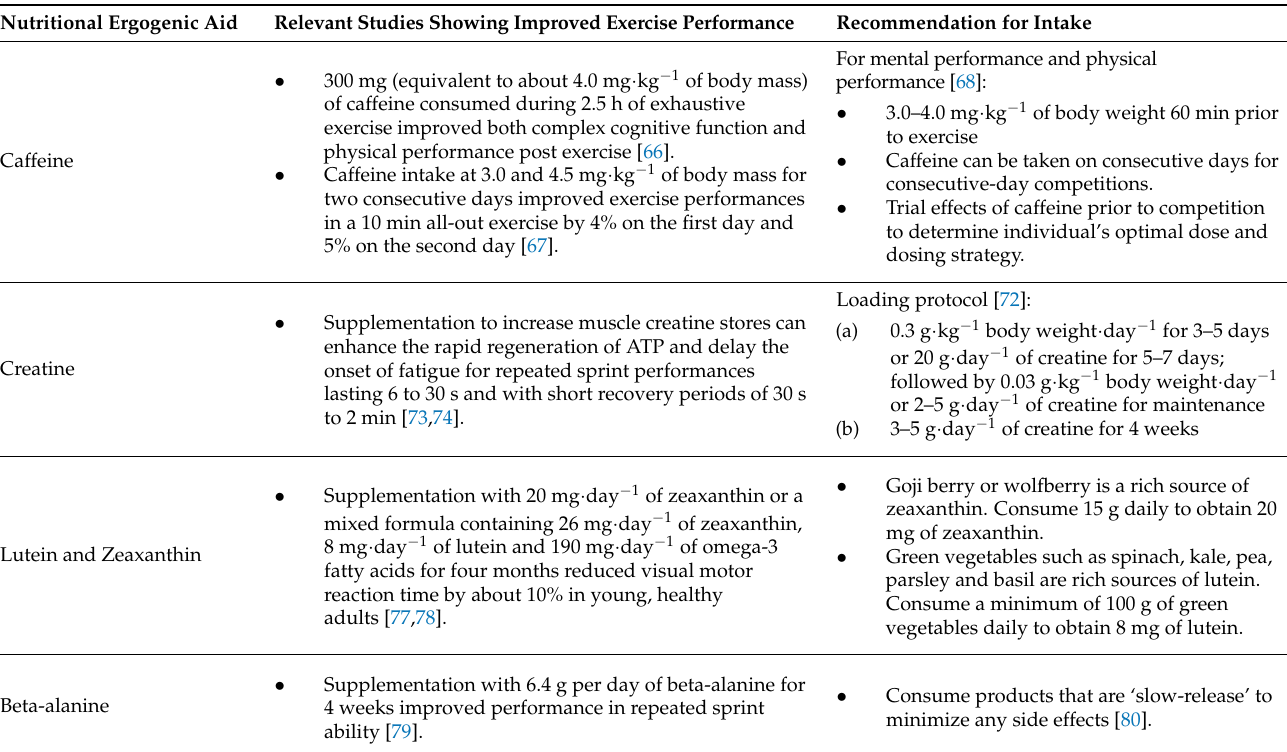
Table 2. Nutritional ergogenic aids of benefit to table tennis—Evidence and recommendations for